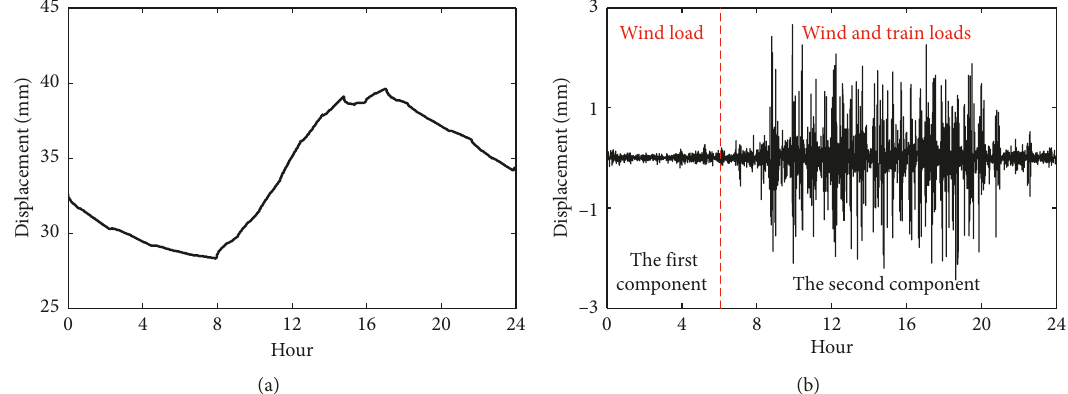
Figure 5: Decomposition result of monitored longitudinal displacement. (a) Component caused by temperature field. (b) Component caused by dynamical loads. Variable